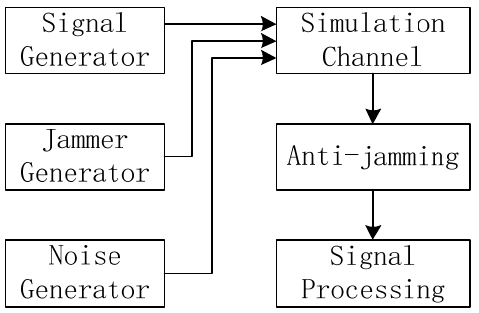
Figure 12. Software receiver simulation block diagram.